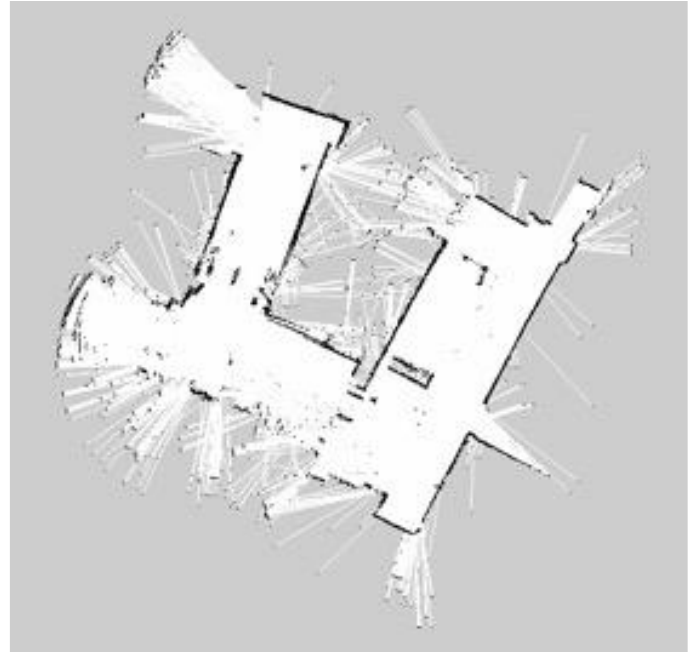
Figure 20. The map using Gmapping (Hokuyo laser rangefinder).